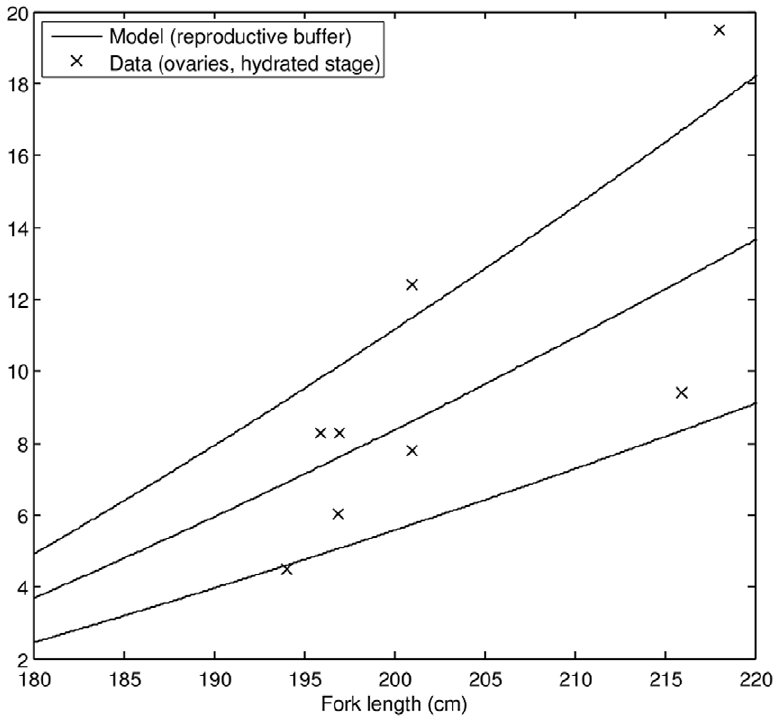
Figure 12. Comparison of predicted and observed ovary weight. Predictions were calculated from simulated reproductive buffer weight (see text). The weight ratio of non-hydrated to hydrated oocytes was set to 0 (the lowest line), 50% (middle line) and 100% (the uppermost line). Only measurements of ovaries with hydrated stage oocytes were selected for this comparison (data source: [44]).